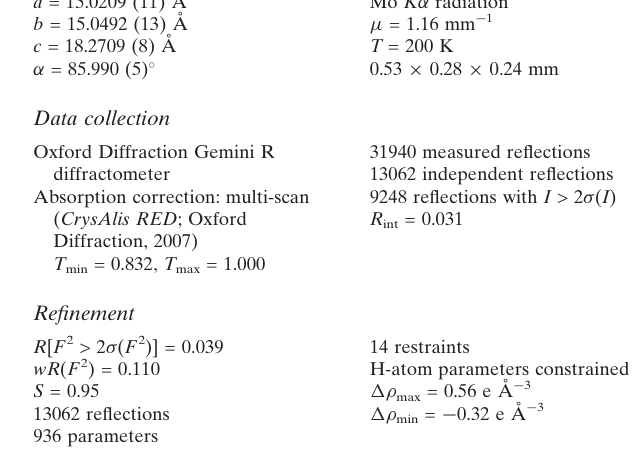
Oxford Diffraction Gemini R diffractometer